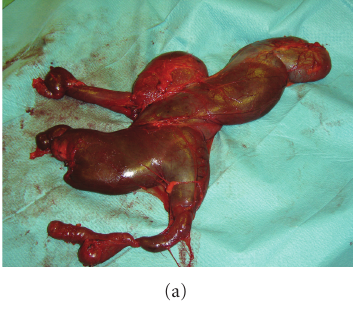
appendages (Figures 5(d) and 5(e)) (ectodermal compo- nent).